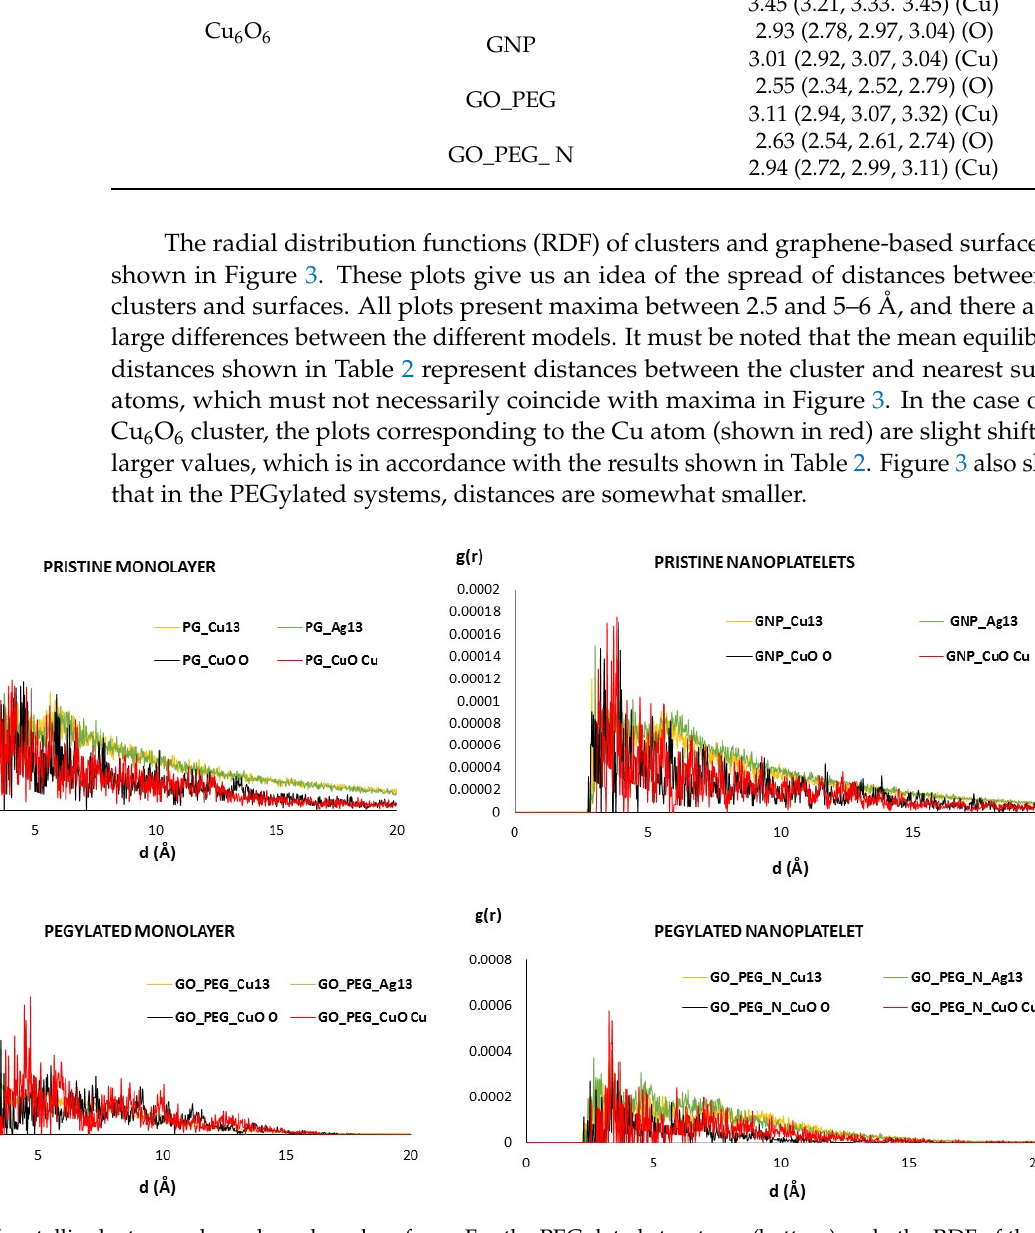
Figure 3. RDF of metallic clusters and graphene-based surfaces. For the PEGylated structures (bottom), only the RDF of the clusters and the nearest chains of PEG are shown.